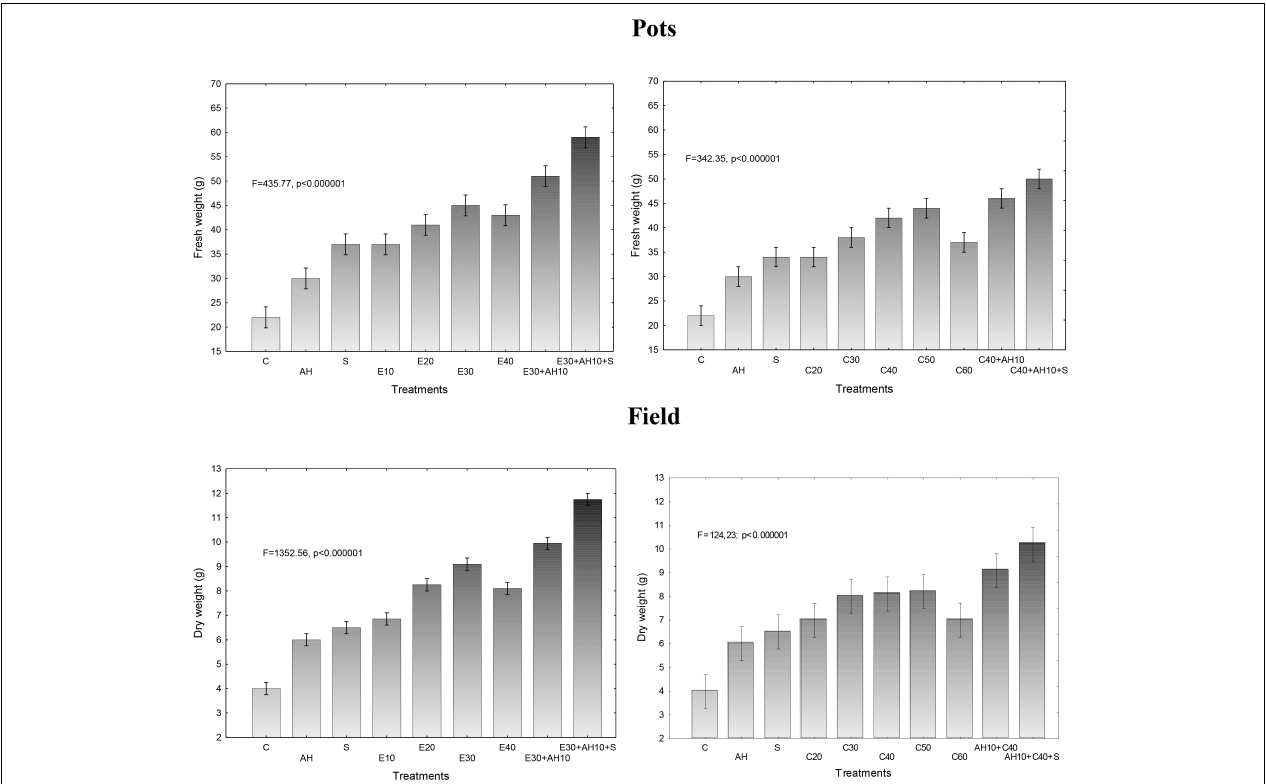
FIGURE 3 | Final fresh and dry weight of one sorghum plant cultivated in pots fertilized with liquid waste from a biomass biodigestion to methane, non-centrifuged (E 10–40 m 3 ha − 1 ) and centrifuged (C 20–60 m 3 ha − 1 ), Apol-humus (AH; 10 L ha − 1 ) and Stymjod (S; 5 L ha − 1 ).